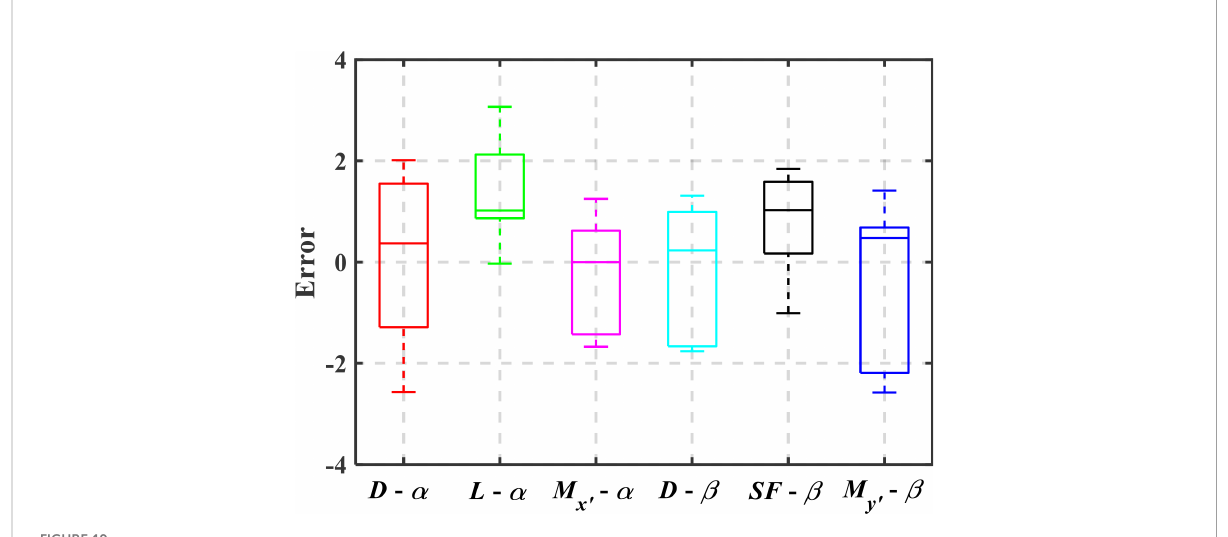
FIGURE 19 The absolute error of CFD simulation and fl ume